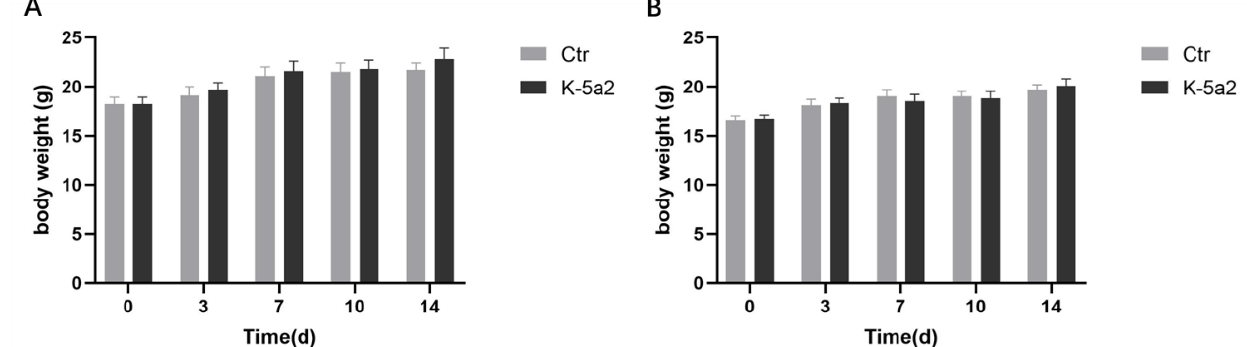
Figure 7. Assessment of acute toxicity. The body weight changes of male ( A ) and female ( B ) BALB/c mice after single oral doses of 5000 mg/kg.